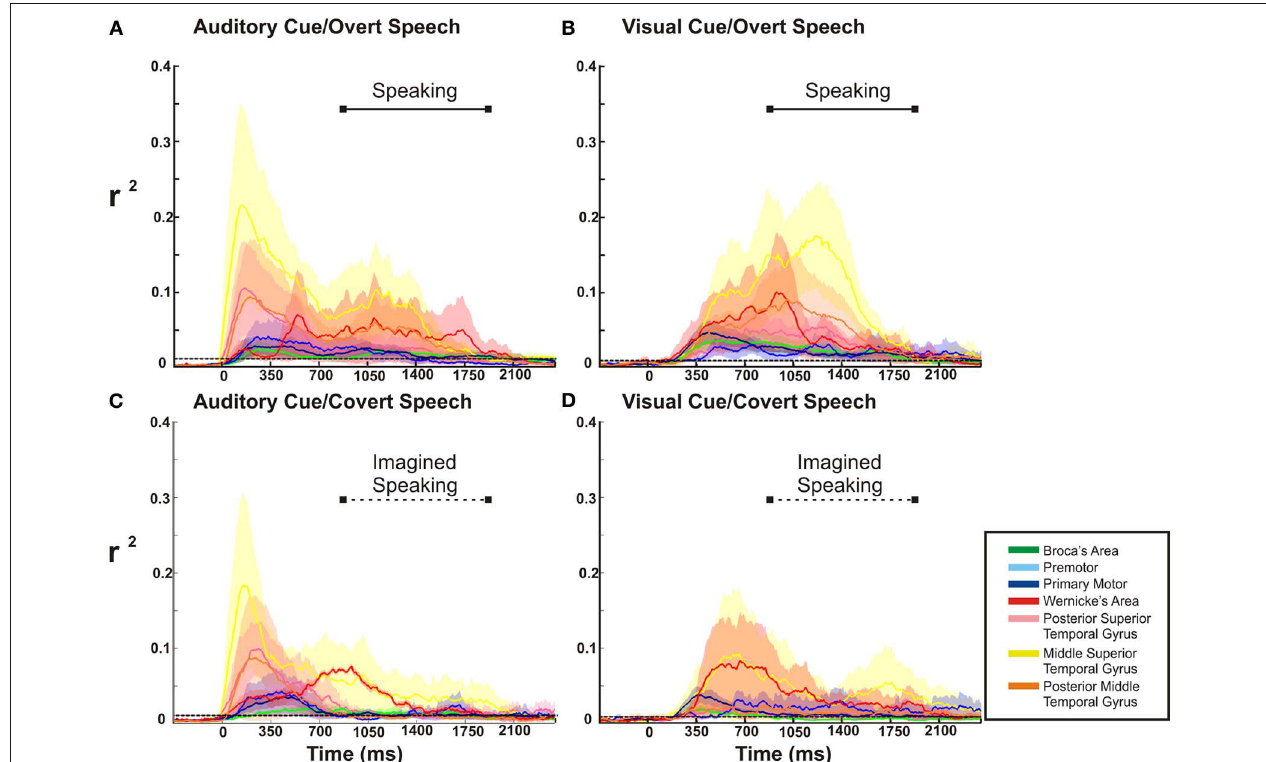
FIGURE 7 | ECoG high gamma r 2 time courses throughout the whole task period (0 represents the time of stimulus presentation). In the over speech conditions, the barred solid horizontal line in the upper quadrant of each figure represents the mean time duration of voice recorded speech. This time duration of speaking is replicated for the covert speech condition,